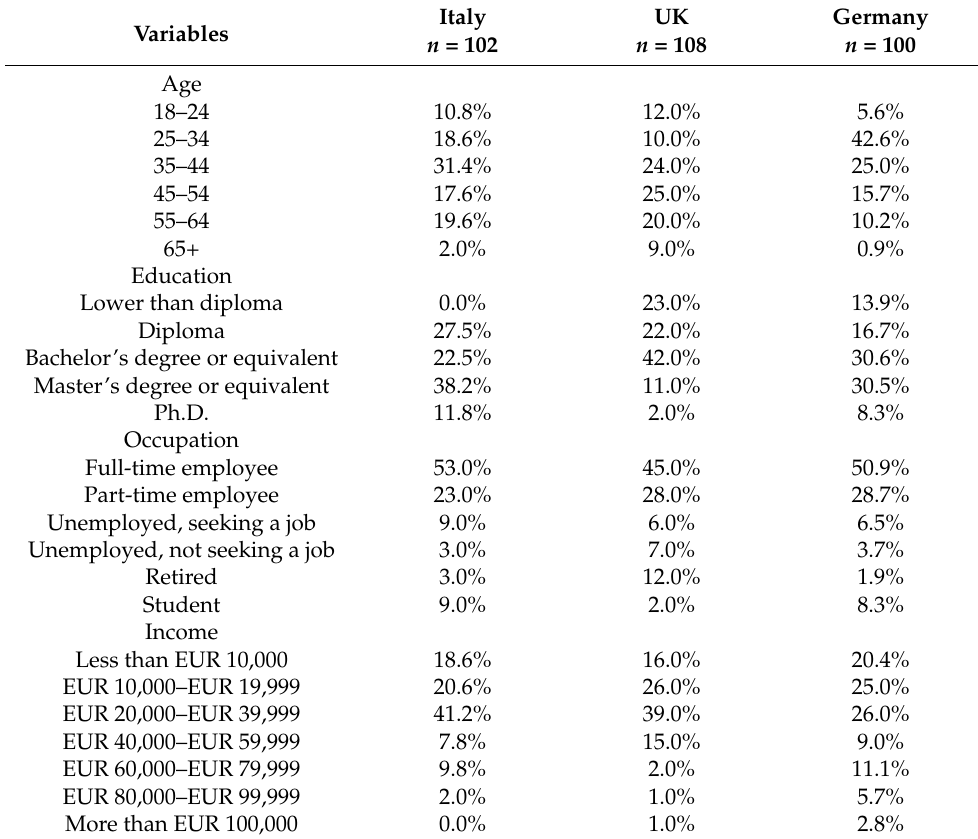
Table 1. Details of sample size by country and socio-demographic